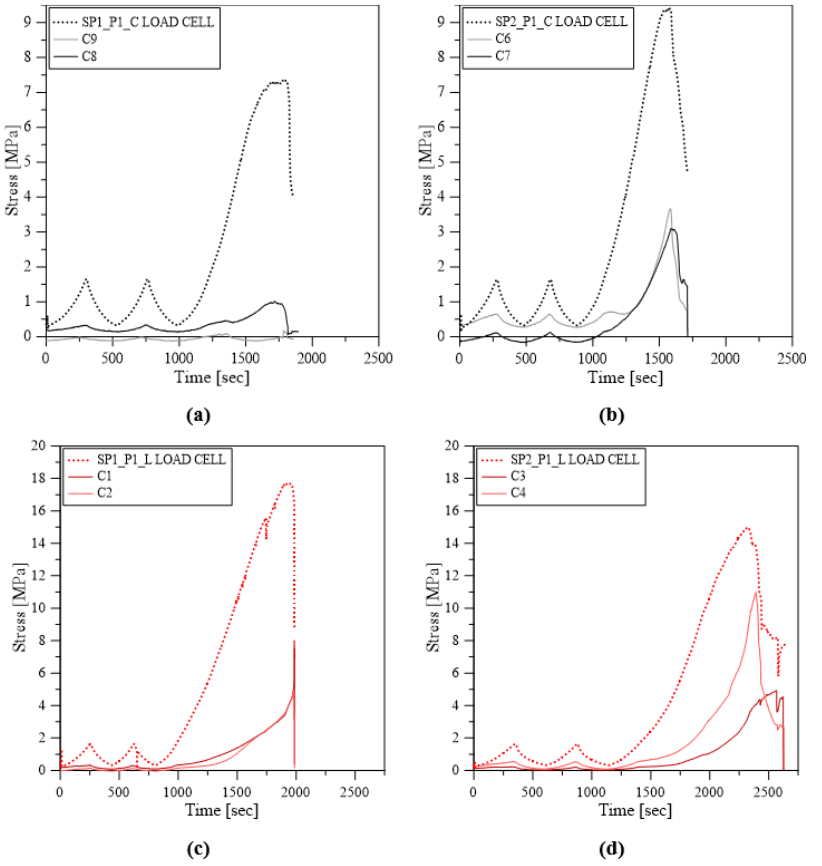
Figure 10. Comparison of outcomes from ceramic sensor and load cell for post-installation system